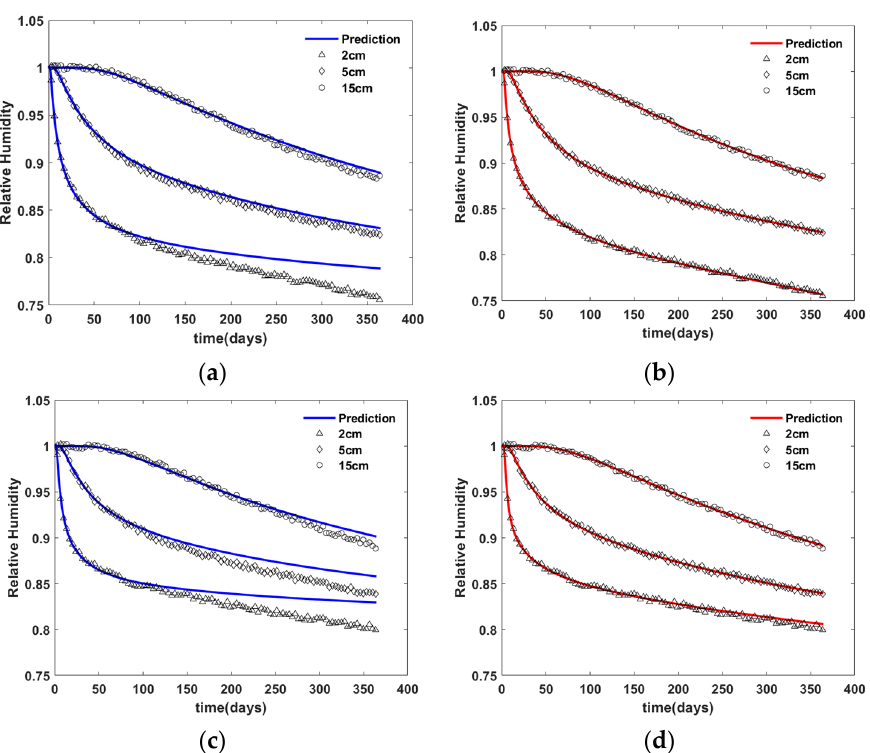
Figure 15. Comparison of virtual experimental data with the predicted data based on ANN N2— ( a ) material M1 and 90 day observation, ( b ) material M1 and 180 day observation, ( c ) material M2 and 90 day observation, and ( d ) material M2 and 180 day